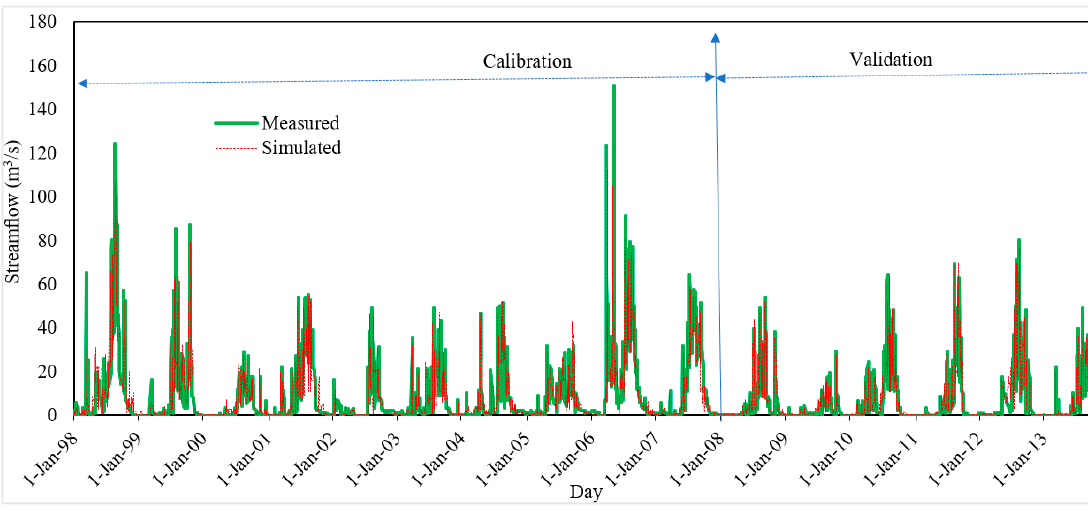
Figure 5. Daily stream flow calibration and validation at Maki gauging station. Table 1. Daily streamflow calibration and validation model performance